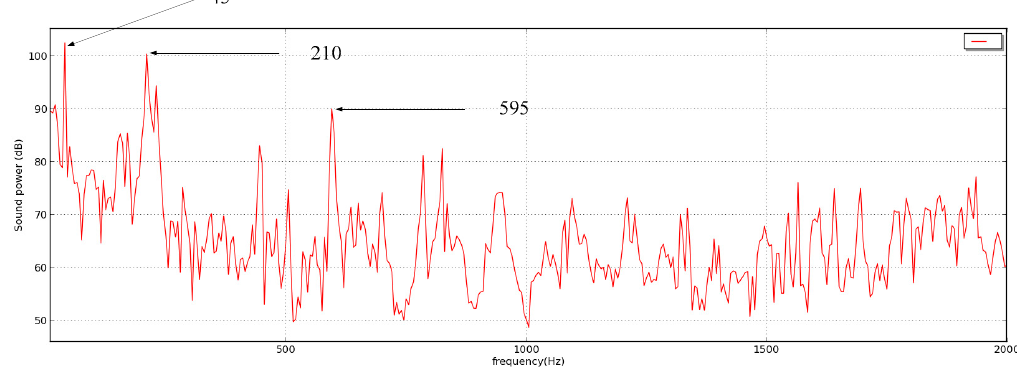
Figure 13. Sound radiation power of the sail hull. In the low-frequency range, some peaks can easily be observed, while in the high-frequency range, the curve of the sound radiation power is rather continuous.